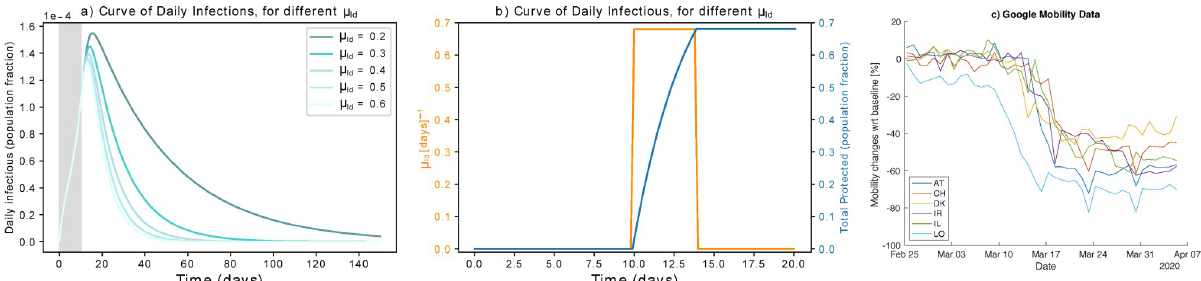
Fig 4. Effect of step-wise hard lock-down. (a) Flattening the infectious curve by hard lockdown. Rapidly isolating a large population fraction is (orange) is active for four days to isolate and protect a large effective in mitigating the epidemic spreading. (b) Modeling hard lockdown: high μ ld population fraction rapidly (blue). As an example, we show μ ld = 0.28 d − 1 if t 2 [10, 14]. It results in protecting about 68% of the population in two days. Higher values, e.g. μ = 0.65 d − 1 would protect 93% of the population at once. (c) Google Mobility Report visualization [30] for analysed countries, ld around the date of measures setting. Each line reports the mean in mobility change across Retail & Recreation, Grocery & Pharmacy, Transit stations, and Workplaces, around the date of implementation of the measures. A minimum of four days (from top to bottom of steep decrease) is required for measures to be fully effective. Abbreviations explanation: AT = Austria, CH = Switzerland, DK = Denmark, IL = Israel, IR = Ireland, LO = Lombardy.